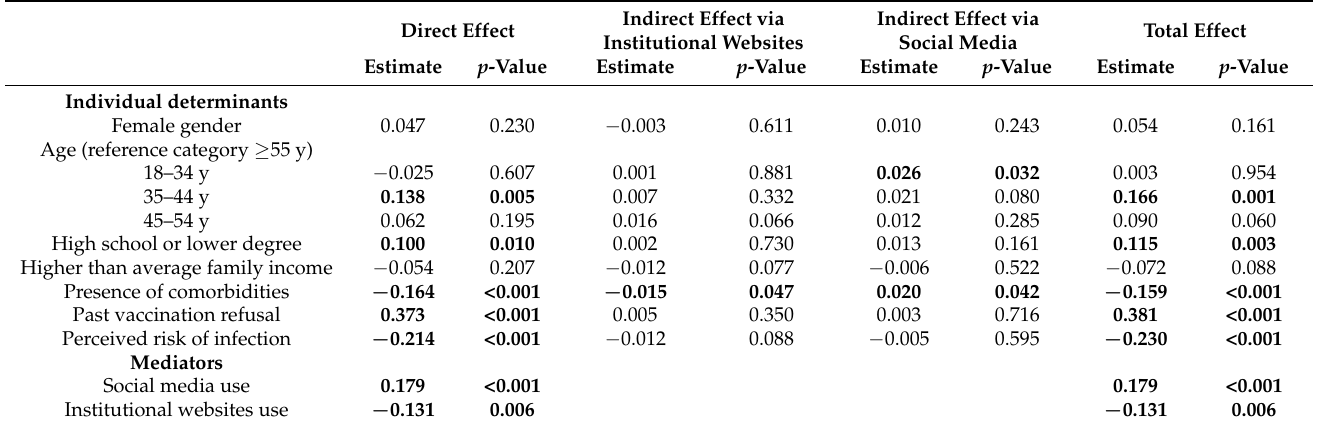
Table 3. Standardized direct, indirect, and total effects on vaccine